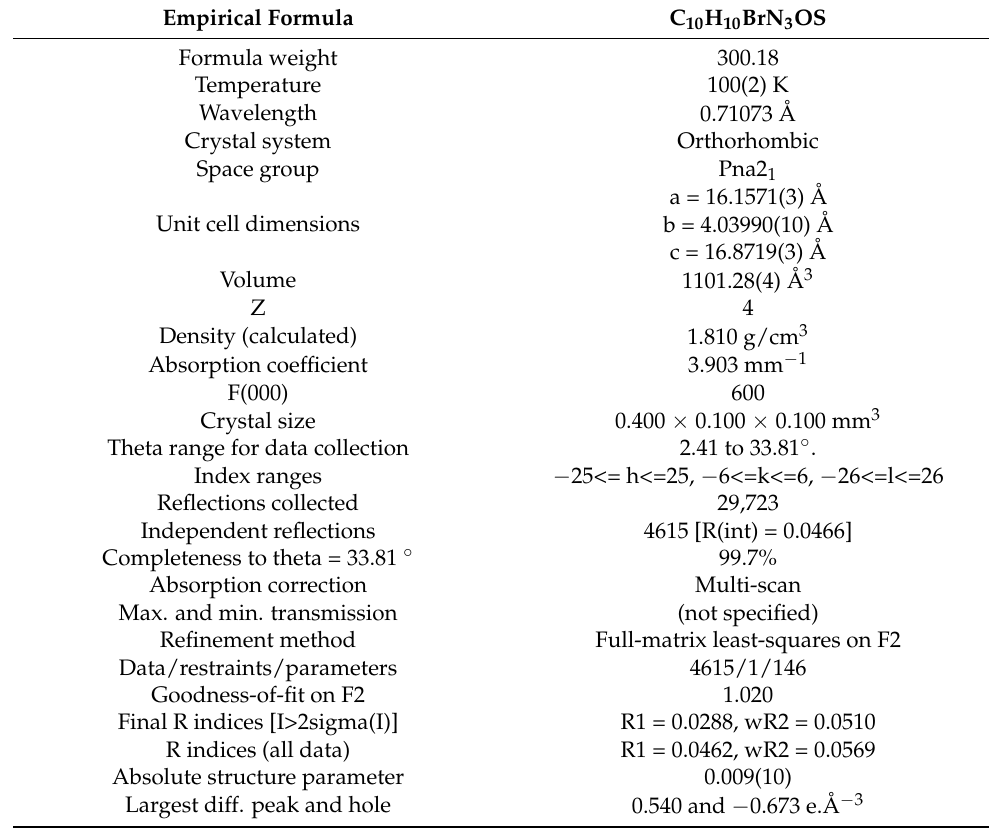
Table 2. Crystal data and structure refinement for compound 2